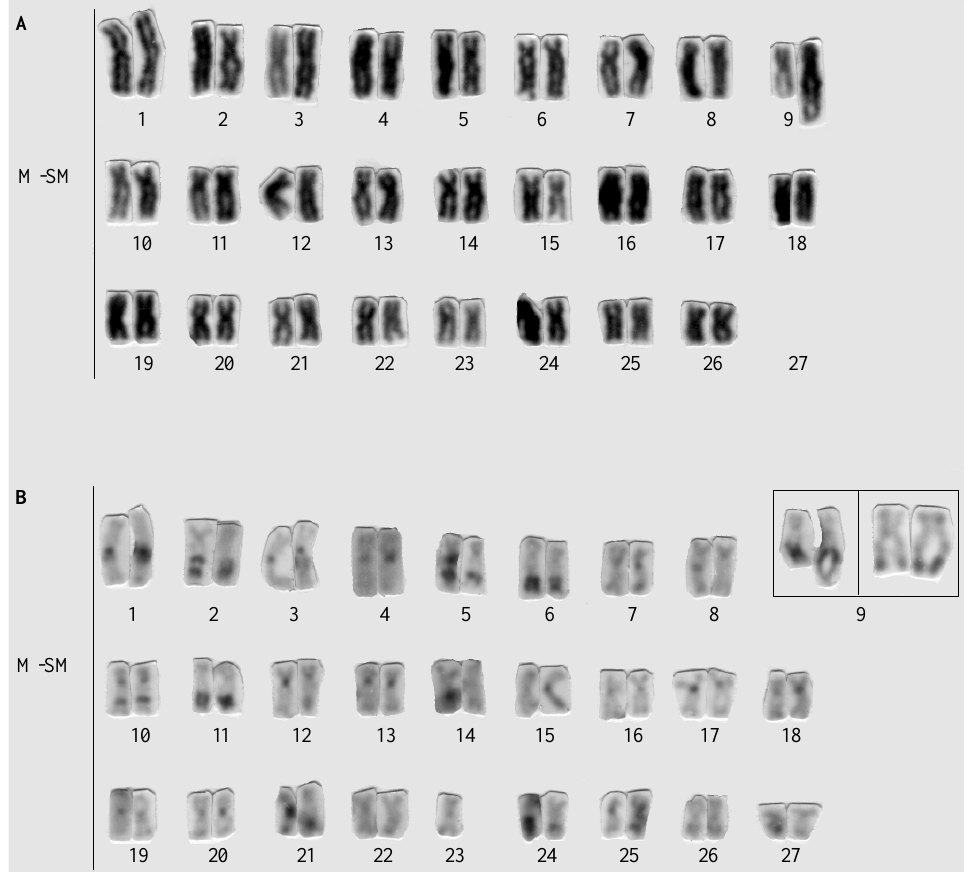
Figure 1 - Giemsa-stained ( A ) and C-banded ( B ) karyotype of Leporinus desmotes female . The NOR-bearing chromosomes (9th pair) are framed: C-banded (left) and silver nitrate stained